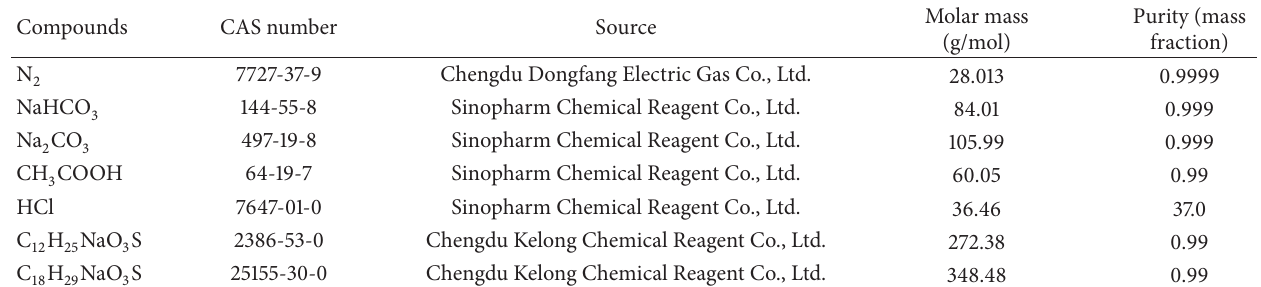
Table 1: Source and purity of the reagents